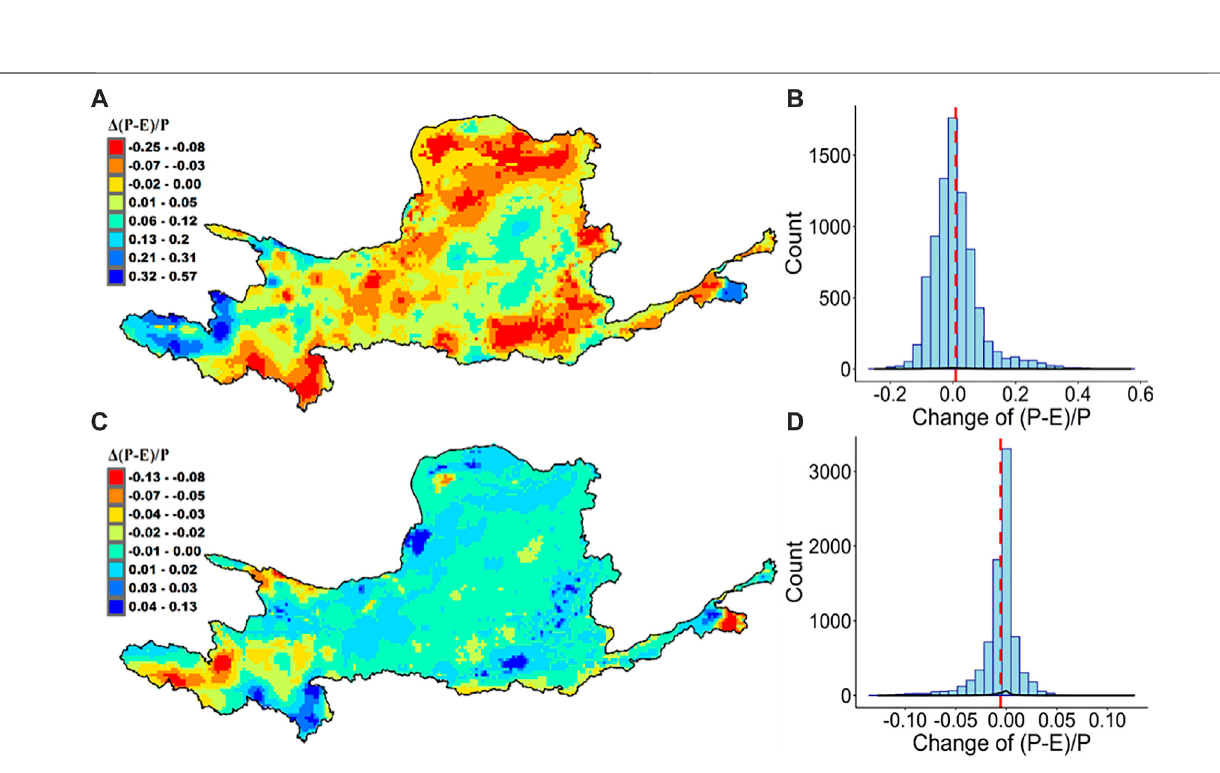
Frontiers in Environmental Science |